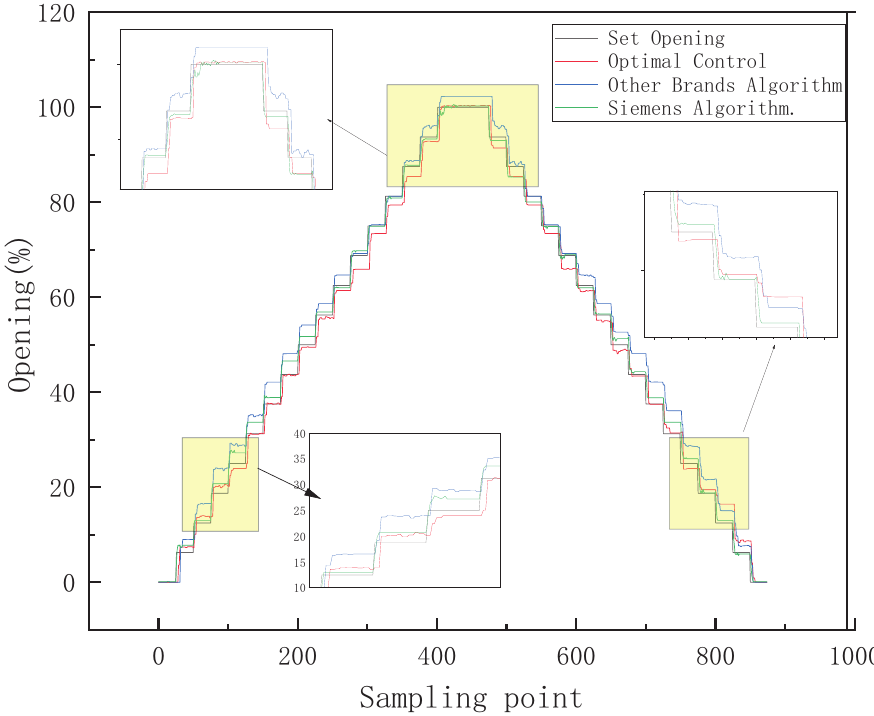
Figure 18. Small-range control algorithms comparison. Table 1. Comparison of small-range intake control